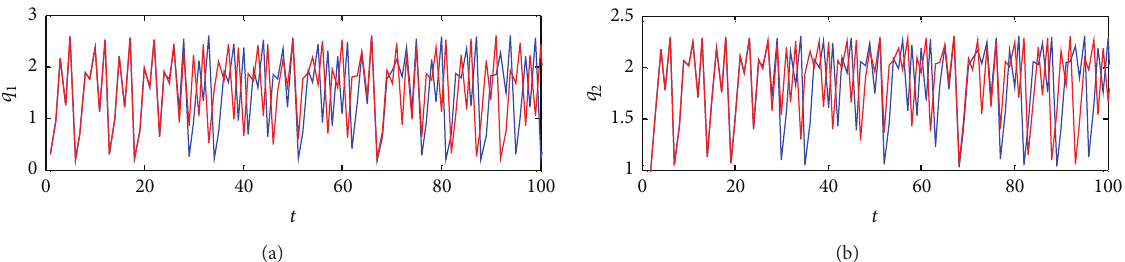
Figure 4: The sensitive dependence on initial conditions; (a) the two orbits of 𝑞 1 -coordinates and (b) the two orbits of the 𝑞 2 -coordinates for , 𝑞 ) = (0.3, 0.4) and the parameter 𝛼 = 0.46 system (13) at (𝑞 1 2 0 0